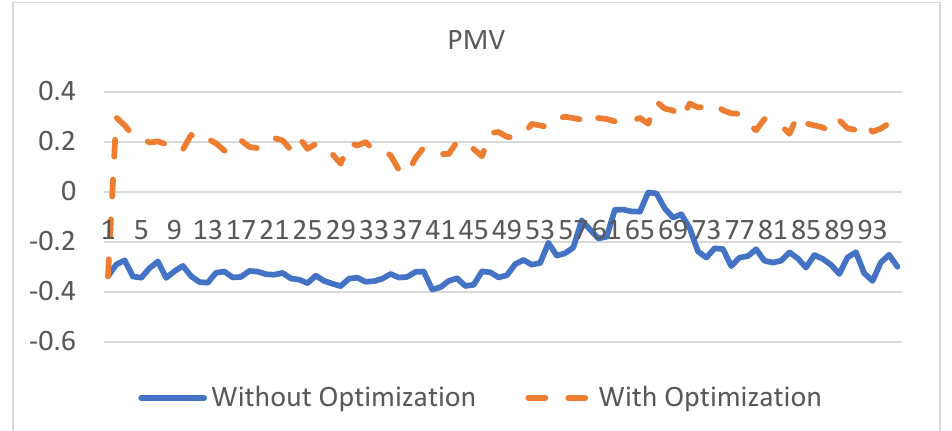
Figure 9. Comparison Results between Current and Optimized Indoor PMV for Efficient Thermal Comfort Control.